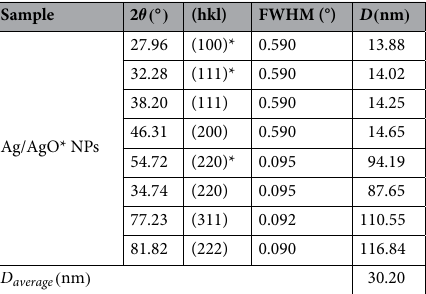
Table 1. The crystallite size of Ag/AgO